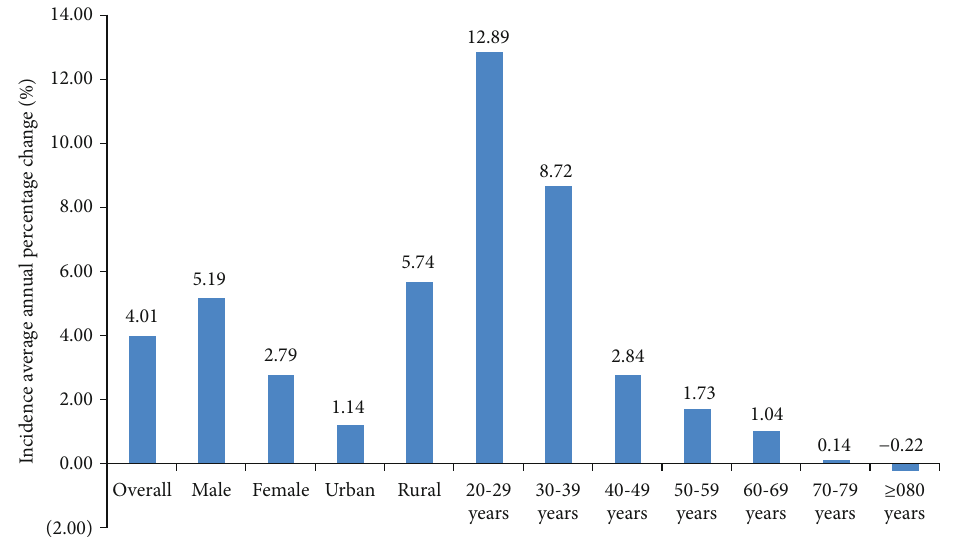
Figure 1: Average annual percentage change of type 2 diabetes incidence by demographic